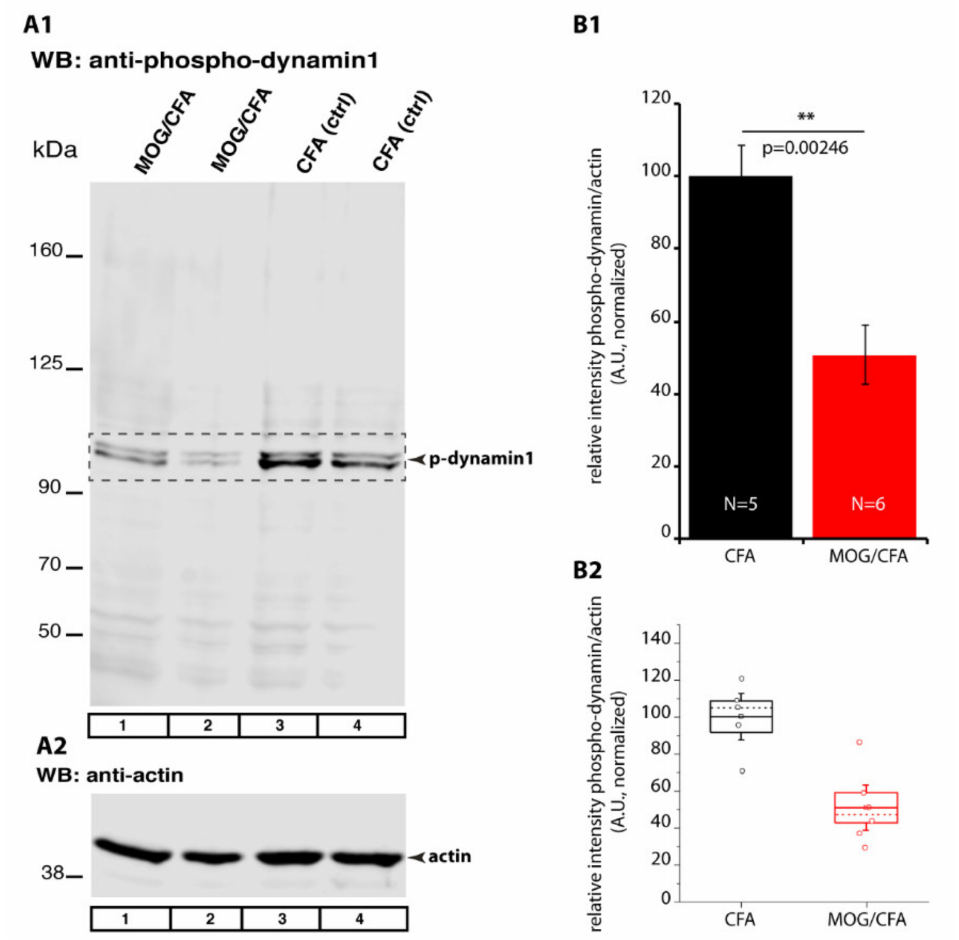
Figure 14. Phospho-dynamin1 expression in the retina of MOG/CFA-injected EAE mice is reduced (WB analyses). ( A1 , A2 ) Retinal lysates isolated from MOG/CFA-injected EAE mice and CFA-injected control mice were probed by WB analyses with anti-phospho-dynamin1 antibody ( A1 ) and anti-actin antibody (loading control) ( A2 ). ( B1 , B2 ) Quantification of phospho- dynamin1 WB bands in MOG/CFA-injected and CFA-injected control using the Li-Cor system. The total fluorescent intensity values of the bands were computed using Image Studio Lite software and normalized to the loading control (actin). The CFA-control was set to 100% to better evaluate the relative change in MOG/CFA-injected EAE vs. CFA control mice. Values in ( B1 ) are means ± S.E.M. In the box-and-whiskers plots ( B2 ) of the data from ( B1 ), mean values are indicated by solid horizontal lines; median values by dotted horizontal lines. Boxes represent 25th–75th percentiles of data points; whiskers are equal to 1.5 times of the interquartile range (IQR). Unpaired Student’s t -test was used to determine statistical significance. N, number of mice; **, p ≤ 0.01; p-dynamin1,